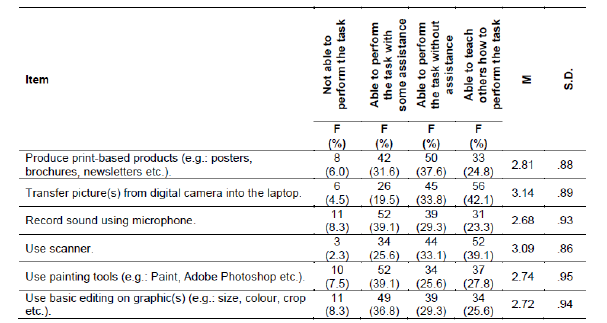
Table 11. Descriptive Statistics for Items on Multimedia Integration using the